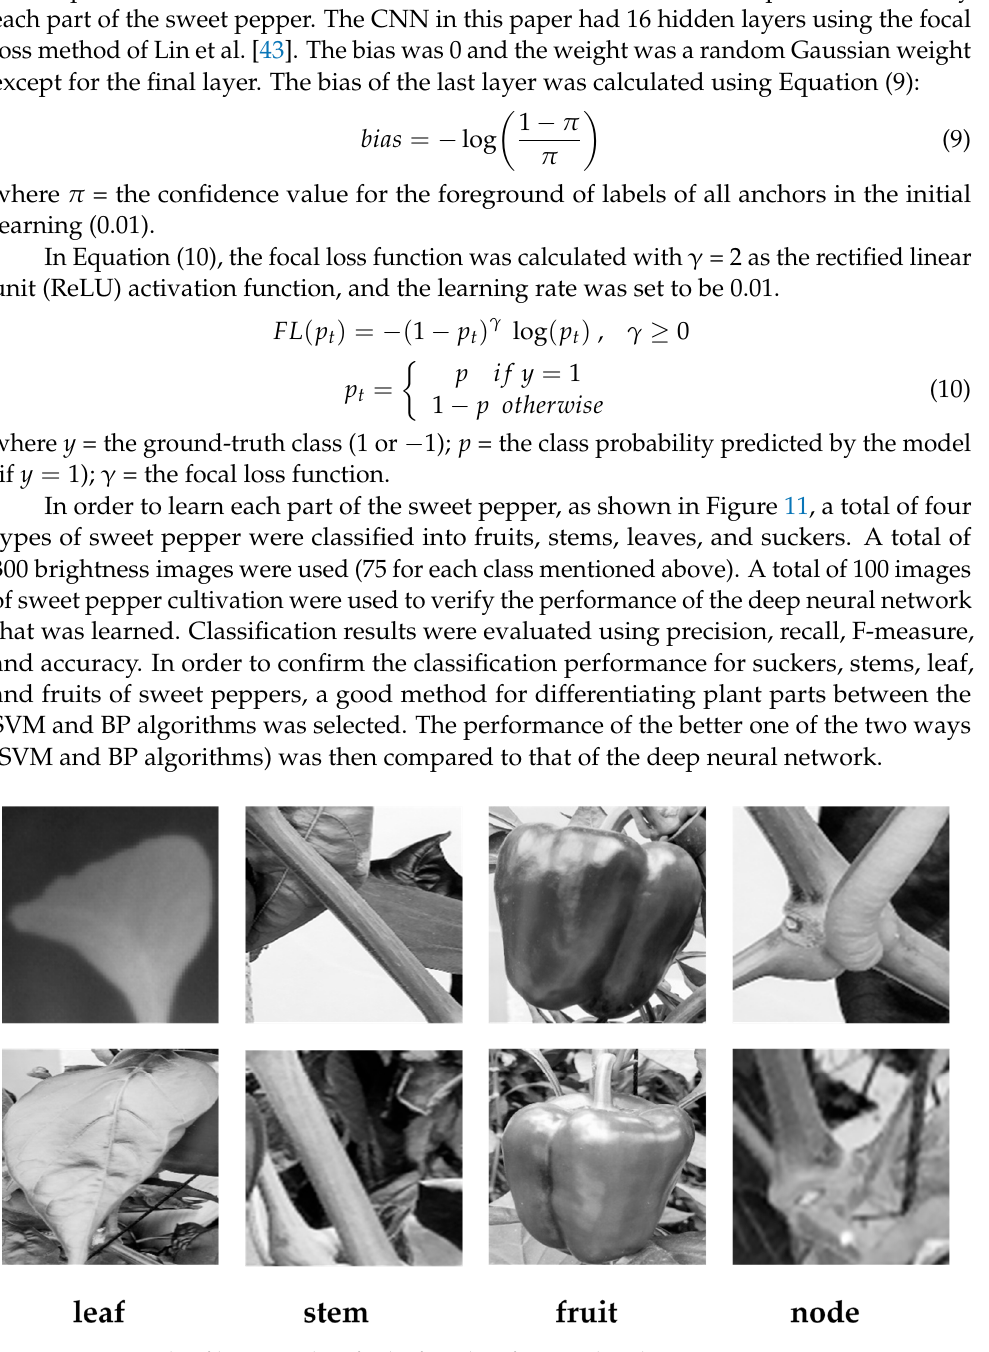
Figure 11. Example of learning data for leaf, sucker, fruit, and node.